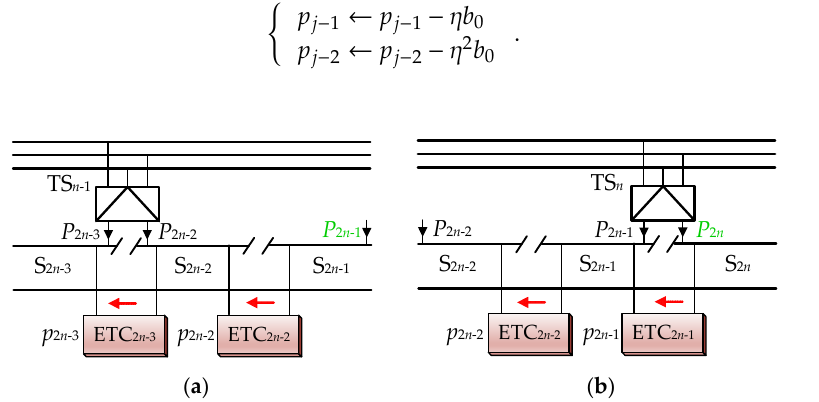
Figure 9. When j ≥ 2 n − 1, the regenerative braking power is transferred by two adjacent converters: ( a ) j = 2 n – 1 and ( b ) j = 2 n .